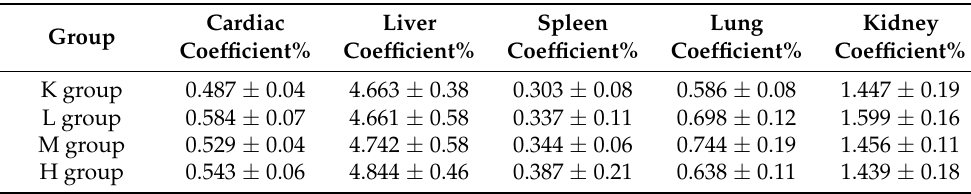
Table 1. Mouse Organ Ratio Index.